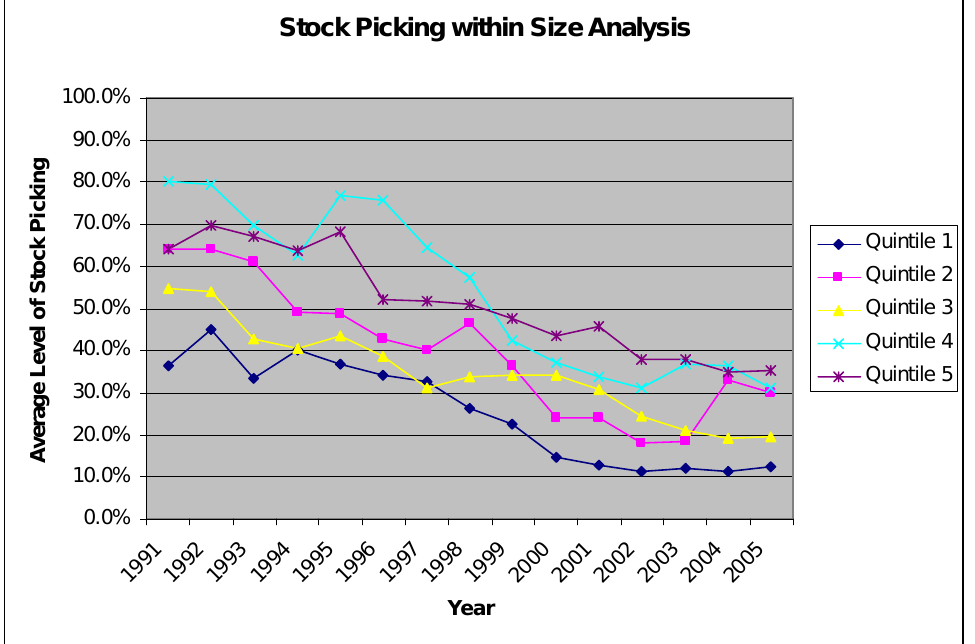
Figure 2: (Maximum Proportion of) Stock Picking in the FTSE350